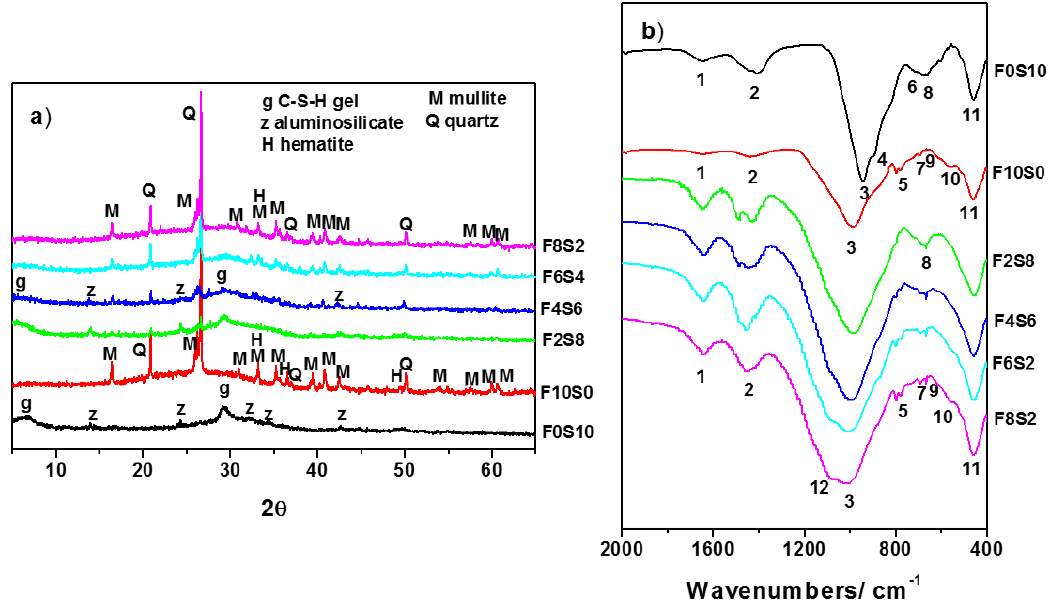
Figure 3. ( a ) XRD patterns; and ( b ) FTIR spectra of the different binders.